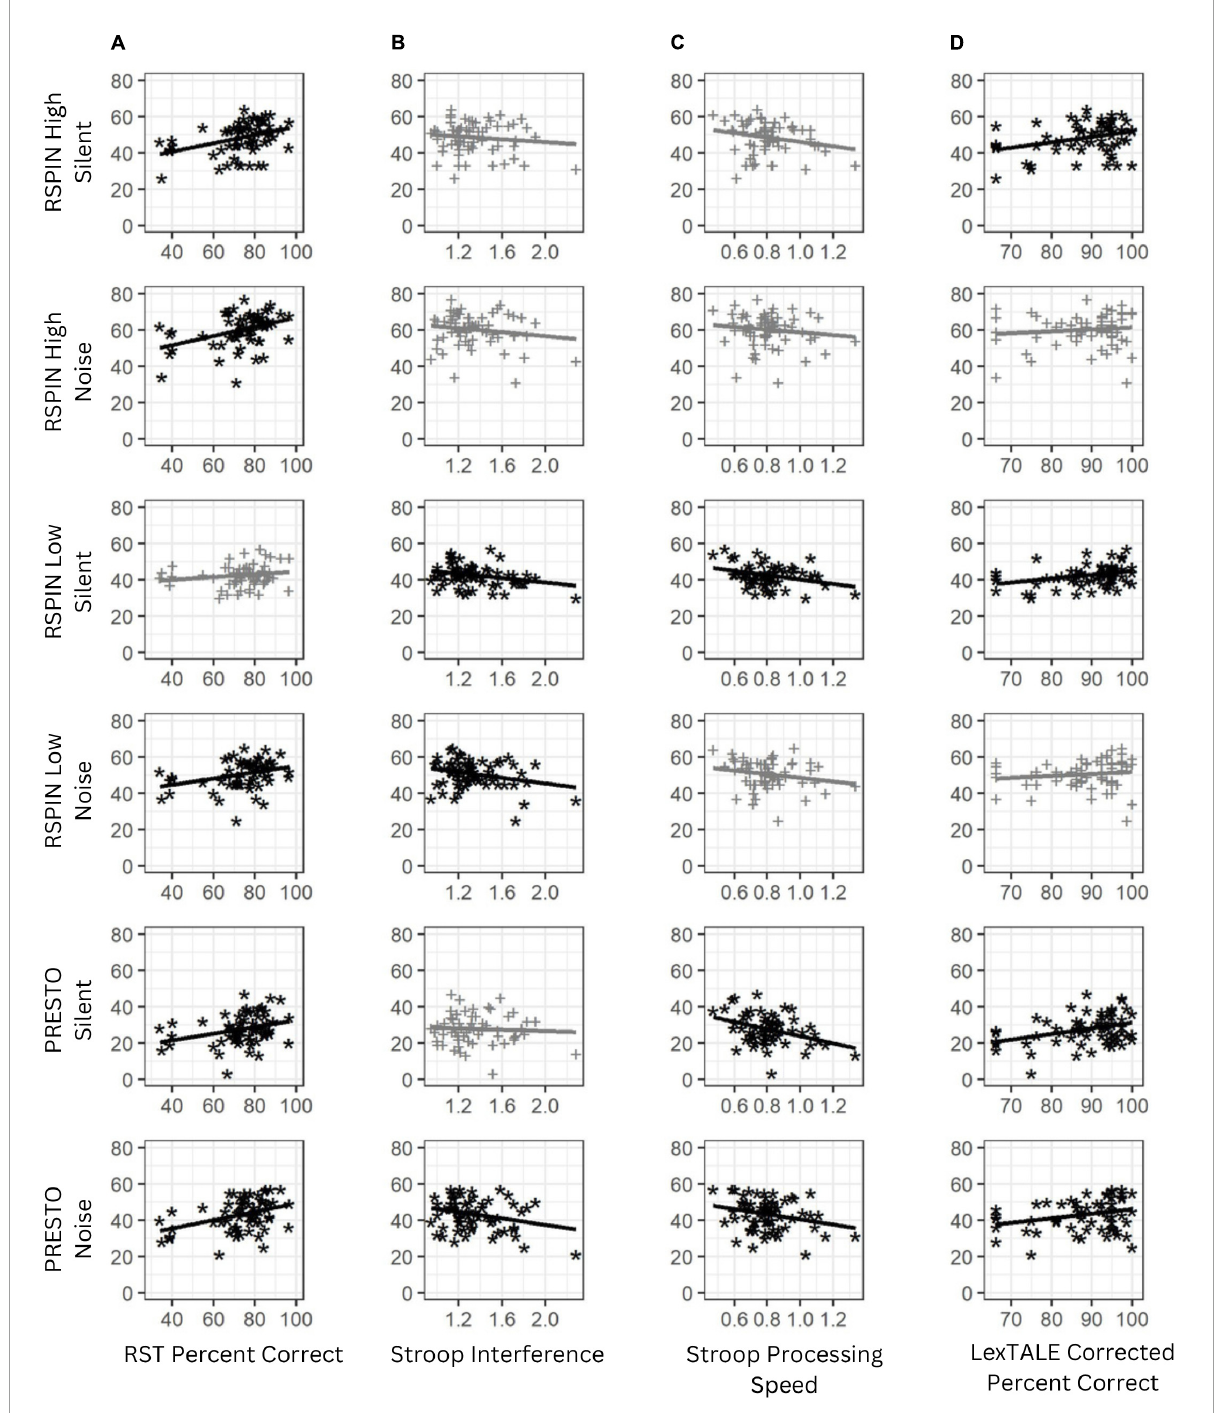
FIGURE2 Scatter plots of perceptual restoration scores for interrupted speech conditions with working memory capacity measured using the reading span test (RST) (A) , inhibitory control measured using the Stroop task (B) , processing speed measured using Stroop reaction time (C) , and lexical accuracy measured using the LexTALE Percent Correct score (D) . Higher scores on RST Percent Correct and LexTALE Percent Correct indicate better performance, while lower scores on Stroop Interference and Stroop Processing Speed indicate better performance. Scatter plots in black with asterisk symbols are statistically significant without correction for multiple comparisons ( p < 0.05) and scatter plots in gray with plus symbols are not statistically significant. Refer to Table 3 for correlation strength and statistical significance for each of these